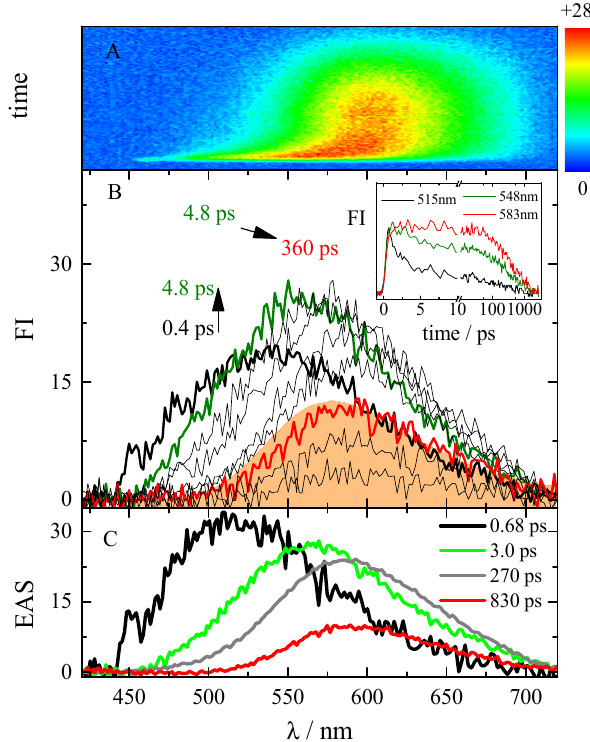
Figure 7. Femtosecond fluorescence up-conversion measurements ( λ exc = 400 nm) of compound DMA-QF in DMF. Panel A: experimental 3D matrix reporting color-coded fluorescence intensity (FI) as a function of wavelength and time; Panel B: representative emission spectra at different delay times and representative kinetics (inset) at different wavelengths together with steady-state emission (orange-shaded area); Panel C: EAS (excited associated spectra) obtained by global analysis.